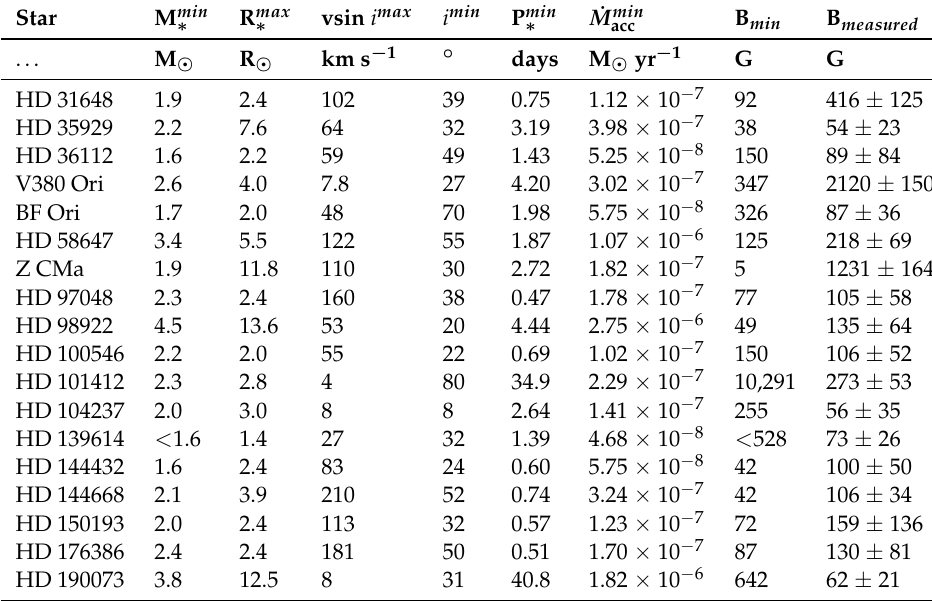
Table 1. Magnetic fields of HAeBe